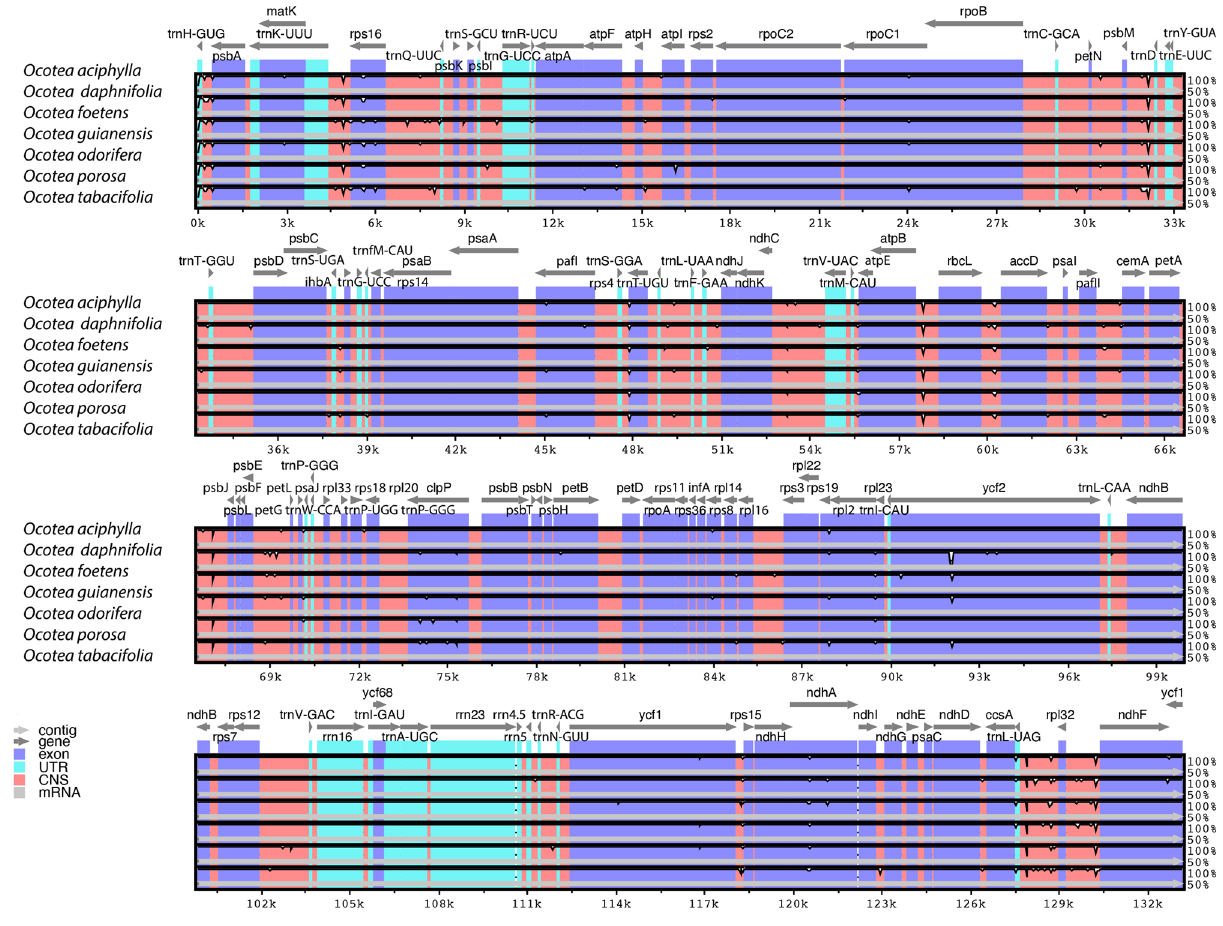
Figure 4. Visualization of Ocotea chloroplast genomes using mVISTA program with O. aciphylla as reference. CNS conserved non-coding sequence; UTR untranslated region.